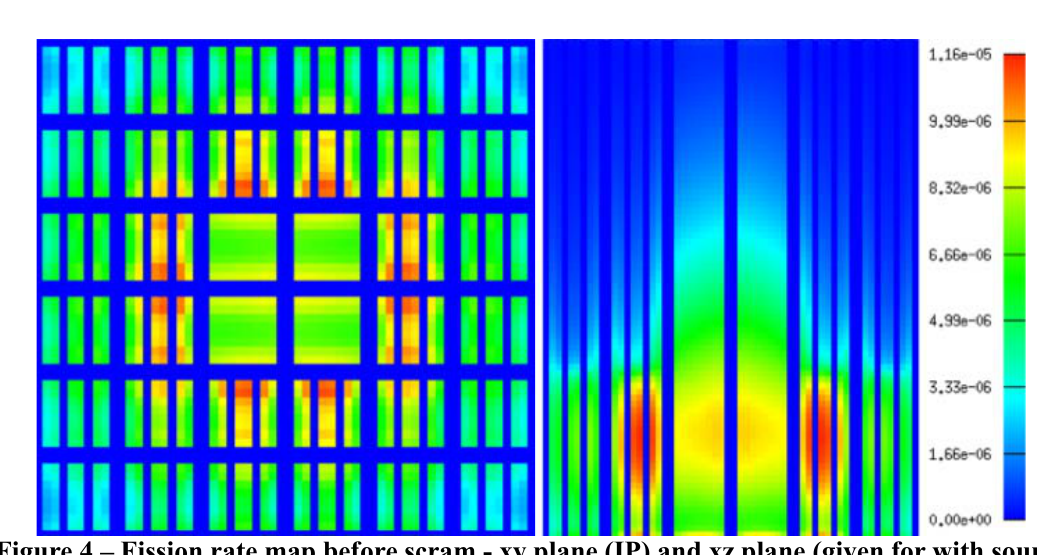
Figure 4 – Fission rate map before scram - xy plane (IP) and xz plane (given for with source neutron normalized to 1 n/s)